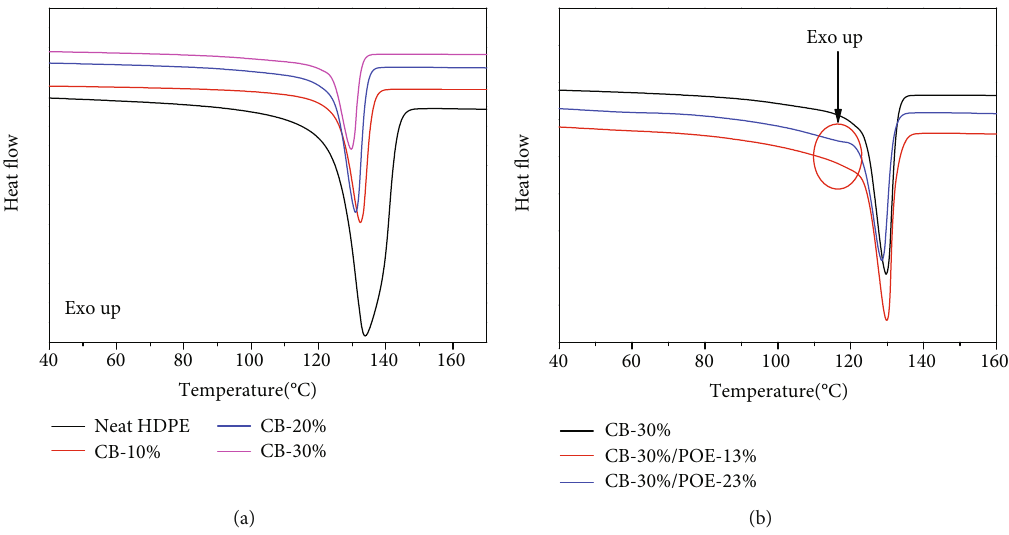
Figure 5: Plot of DSC analysis of HDPE/POE/CB composites with (a) di ff erent CB content and (b) di ff erent POE content.